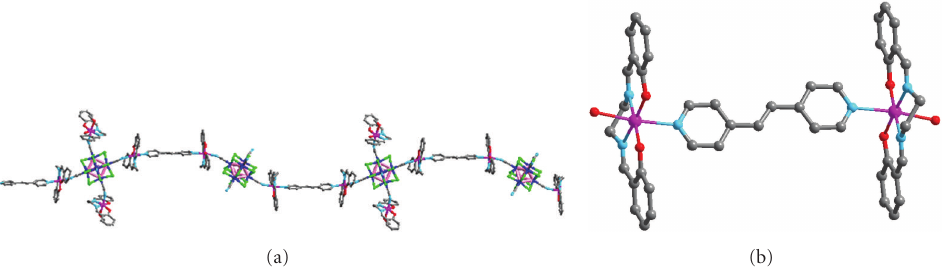
Figure 3: The structure of 3 (a) 1D anionic chain. (b) The cation: { [Mn( Salen )(H 2 O)] 2 (4,4 (cid:2) - bpe ) } 2+ .